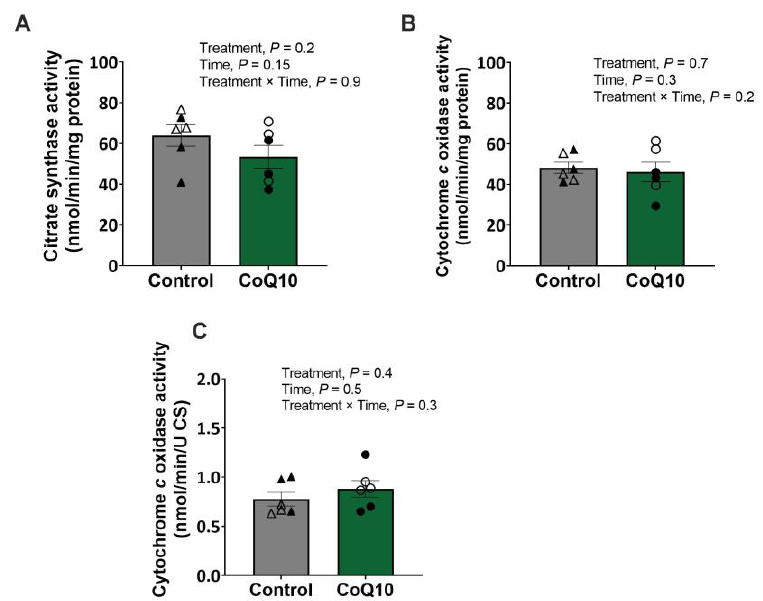
Figure 2. ( A ) CS activity and ( B ) integrative and ( C ) intrinsic CCO activities in the gluteus medius of fit Thoroughbred horses before and after 30 d supplementation of CoQ10 or control diet. Open circles represent horses on the CoQ10 supplement during the first supplementation period, and closed circles represent horses on the CoQ10 supplement during the second supplementation period. Open triangles represent horses on the control diet during the second supplementation period, and closed triangles represent horses on the control diet during the first supplementation period.